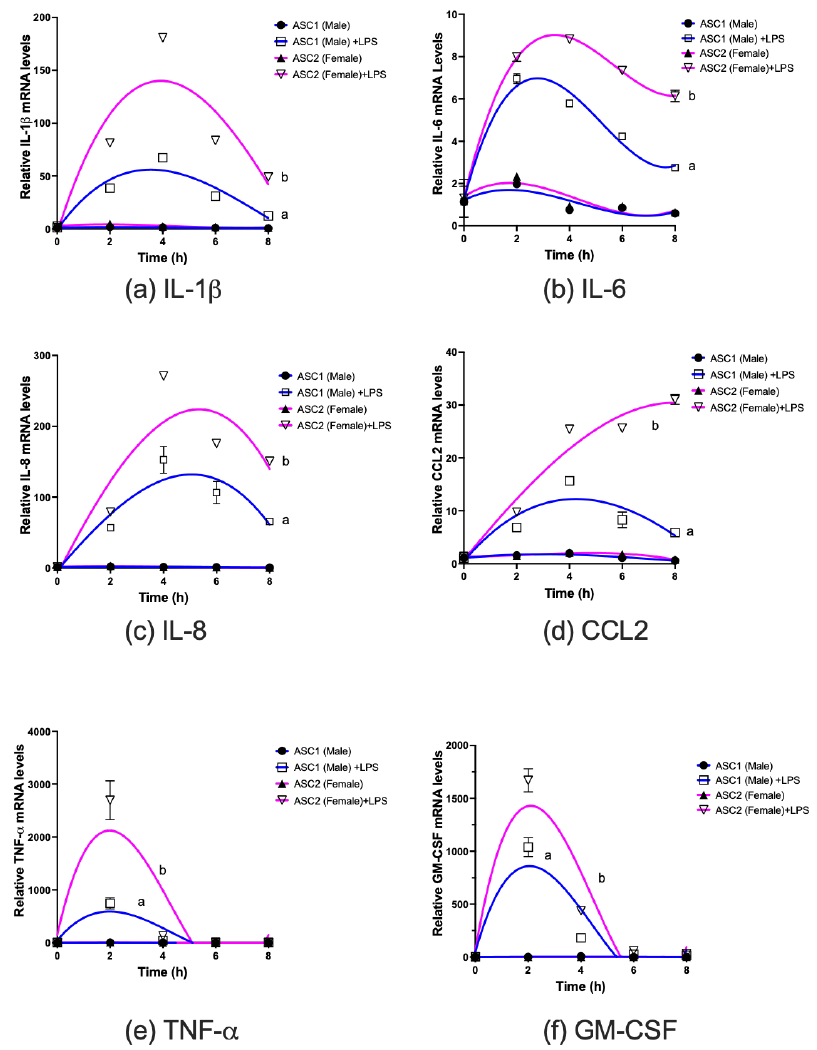
Figure 3. Individual adipose stem cells (ASCs) differentially induce cytokines mRNA expression in response to inflammatory stimuli. ASCs were cultured and treated with or without LPS (10 ng/mL), cells were harvested at different time points and total RNA was isolated as described in Materials and Methods. Selected inflammation-associated cytokines mRNA levels were determined using RT- PCR as described in Materials and Methods. Results expressed as relative mRNA levels (mean +/ − SD, n = 3) to 0 time. Curves with different letter indicate significantly different at p < 0.05 or less. Secretion of selected pro-inflammatory cytokines/chemokines at the protein level was also determined. Both ASCs responded to LPS stimulation and secreted pro-inflam- matory cytokines/chemokines. TNF- α , IL-6, IL-8 and GM-CSF were secreted at higher lev- els (Figure 4). In particular, ASC1 appeared to secrete higher levels of IL-6 (Figure 4a) at baseline ( p < 0.0001) as well as in response to LPS stimulation ( p < 0.0001) than ASC2. ASC1 secreted higher levels of IL-8 (Figure 4b) at earlier time points than ASC2 ( p < 0.0001). ASC2 appeared to secrete significantly higher levels of TNF- α and GM-CSF than ASC1 (Figure 4c,d, p < 0.0001). Additional cytokines/chemokines, including IL-2, 4, 10 and IFN- γ, were examined. However, IL-10 was below detection limit under the same assay con- ditions. IL-2, IL-4 and IFN- γ concentrations (Figure S2) were much lower than those